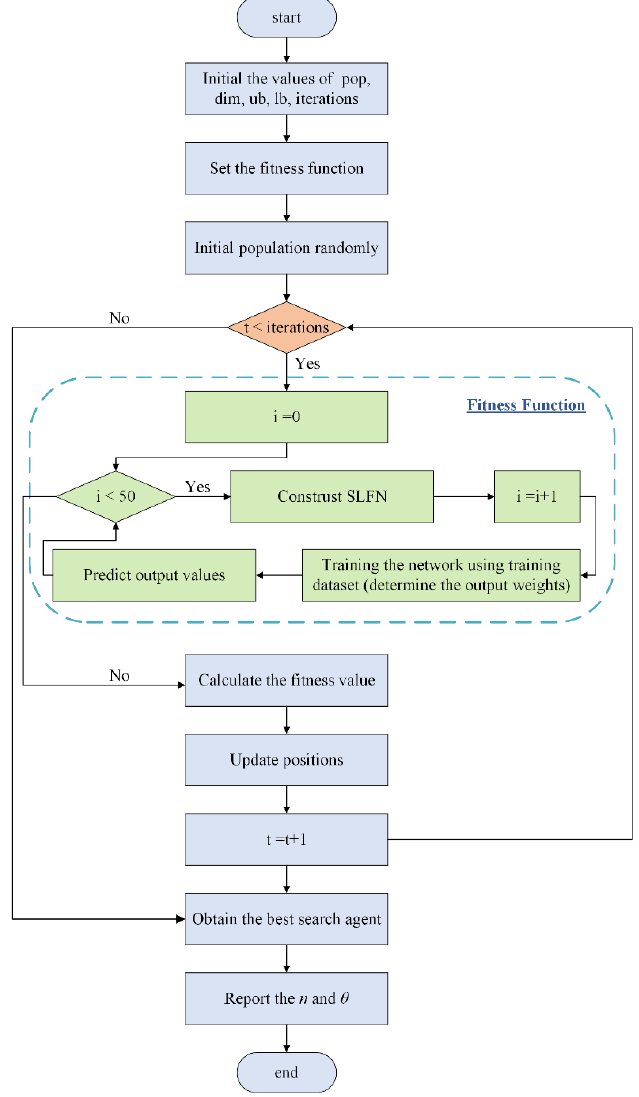
Figure 5. Flowchart of the GWO-RELM algorithm.